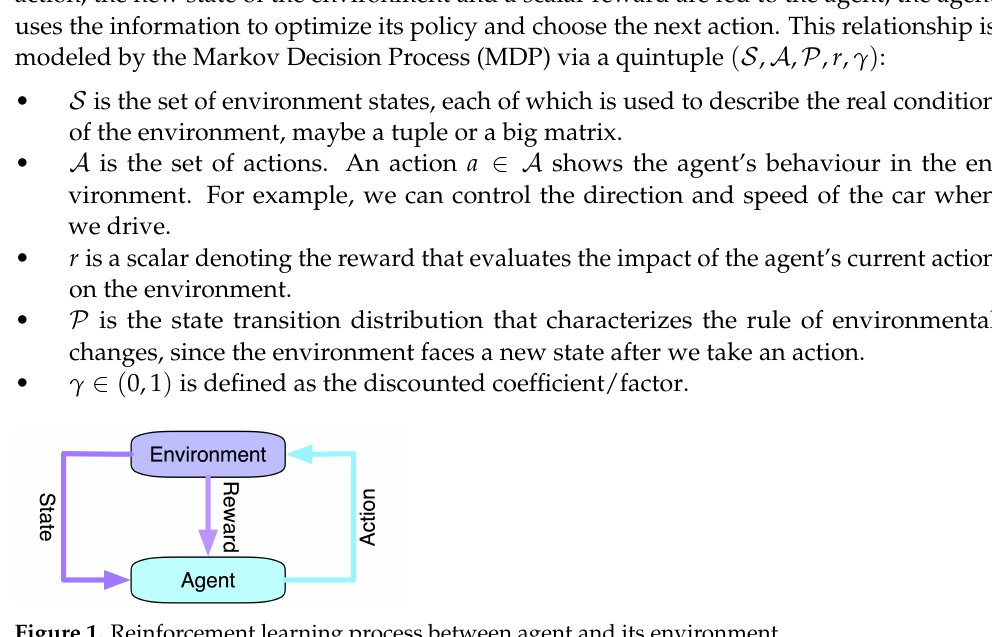
Figure 1. Reinforcement learning process between agent and its